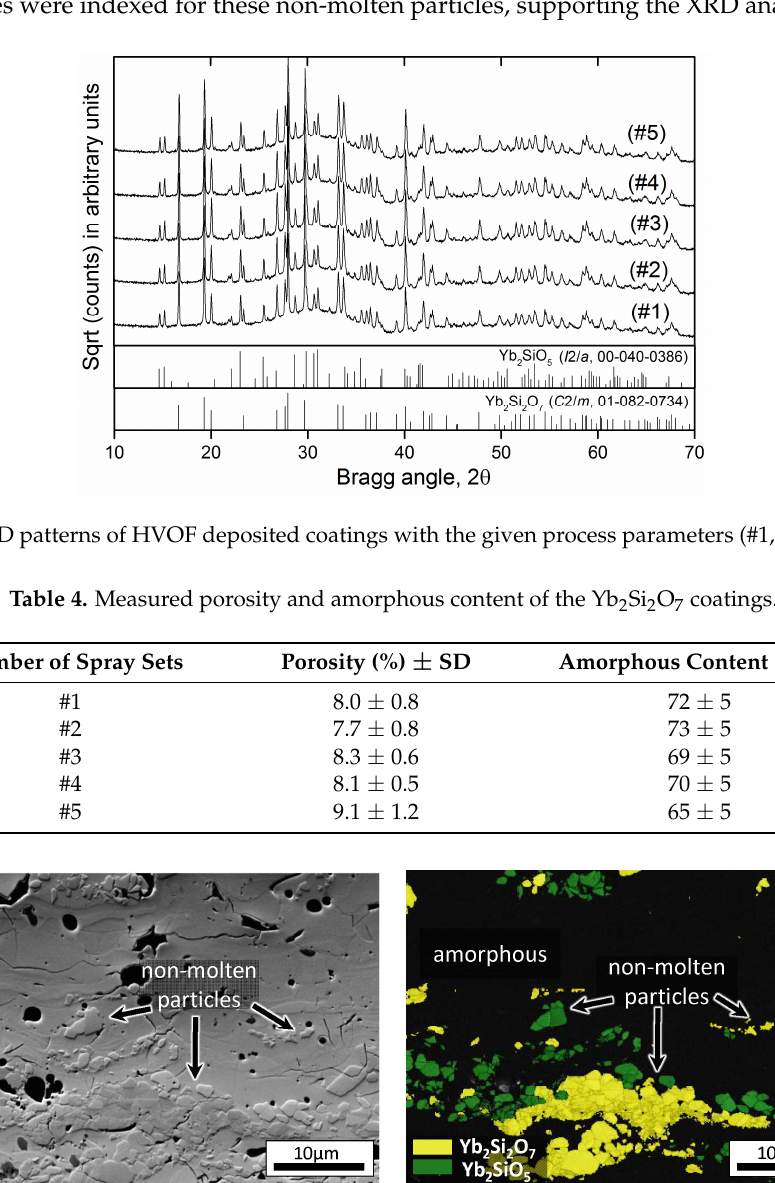
Figure 7. EBSD analysis results of the Yb 2 Si 2 O 7 coating (#2): ( a ) Forescatter diode (FSD) image and ( b ) phase map.